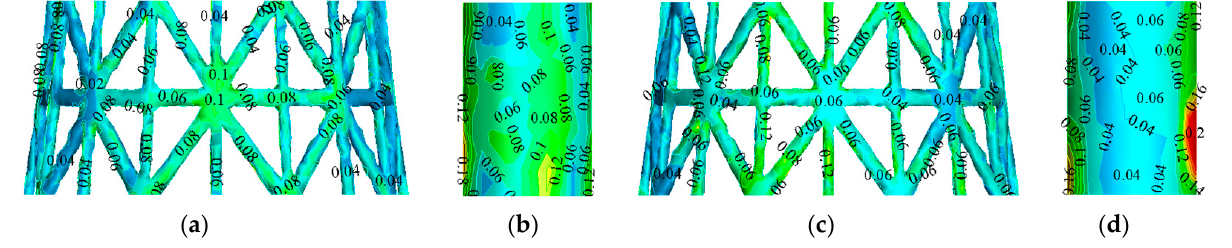
Figure 25. Fluctuating wind pressure coefficient distribution on the 50 m layer: ( a ) Windward side of the grid structure; ( b ) Windward side of the core tube; ( c ) Leeward side of the grid structure; ( d ) Leeward side of the core tube.